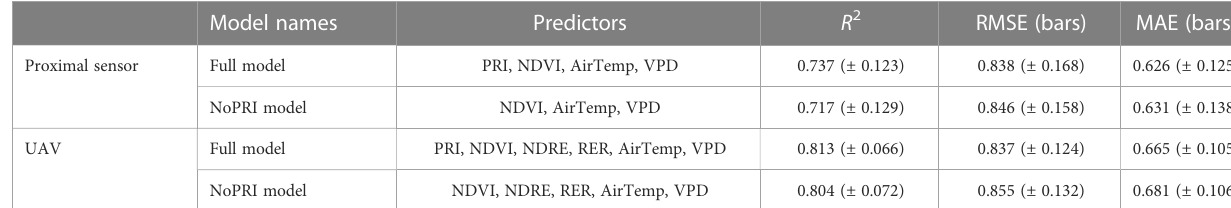
TABLE 3 Random forest model performance in estimating stem water potential ( y stem ) with proximal sensing data and unmanned aerial vehicle data as represented by the cross-validated mean of the coef fi cient of determination ( R 2 ), root mean square error (RMSE), and mean absolute error (MAE) as well as the standard deviation in the